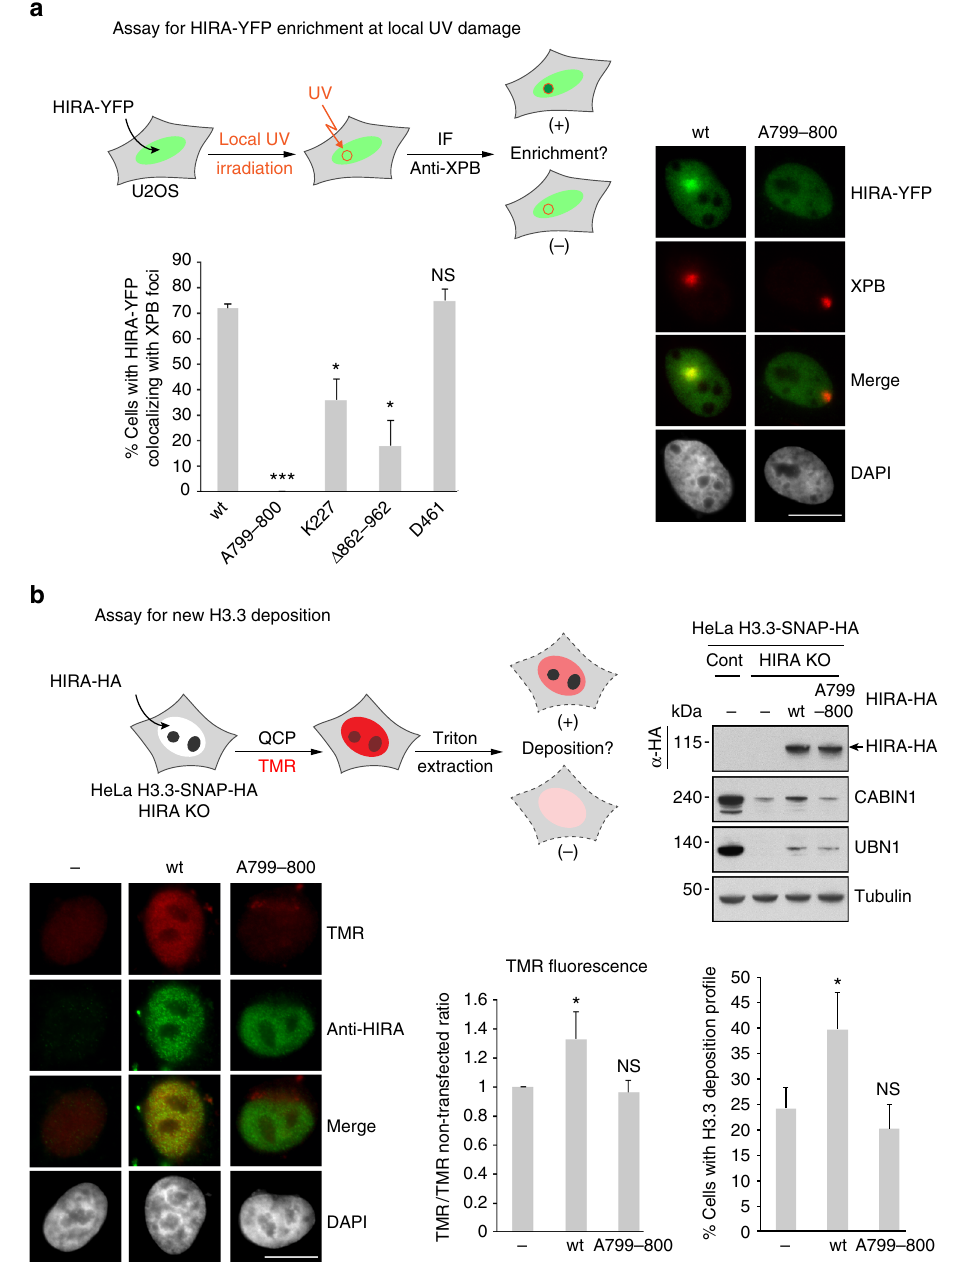
Fig. 6 Homotrimerization of HIRA is critical for its enrichment at UV damaged sites and for new H3.3 deposition. a (Left, top) Scheme of the experimental assay for HIRA-YFP enrichment at local UV damage in U2OS cells. (Left, bottom) The graph shows the percentage of U2OS cells with HIRA-YFP protein colocalizing with XPB foci. Error bars represent SD from three independent experiments. Statistical analysis using a t -test was performed with Prism 7 software (ns: nonsigni fi cant, * p < 0.05, *** p < 0.001). (Right) Images of representative U2OS cells irradiated locally with UV exhibiting an enrichment of left) Scheme of the experimental assay for new H3.3 deposition by a Quench-Chase-Pulse experiment (QCP) in HeLa H3.3-SNAP-HA HIRA KO cells transfected with HIRA-HA constructs. (Top, right) Western blot analysis showing the protein expression of exogeneous HIRA-HA wt and (W799A – D800A) mutant. (Bottom, left) Images of cells subjected to QCP: representative images for a cell non-transfected or transfected with HIRA-HA (W799A – D800A) mutant and a high TMR positive representative image for a cell transfected with HIRA-HA wt. (Bottom, right). One graph shows the fl uorescence intensity ratio TMR/TMR non-transfected. The other graph gives the percentage of cells exhibiting a positive pro fi le for H3.3 deposition. Error bars represent the SD from three independent experiments. Statistical analysis using a t -test was performed with Prism 7 software (ns: nonsigni fi cant, * p <